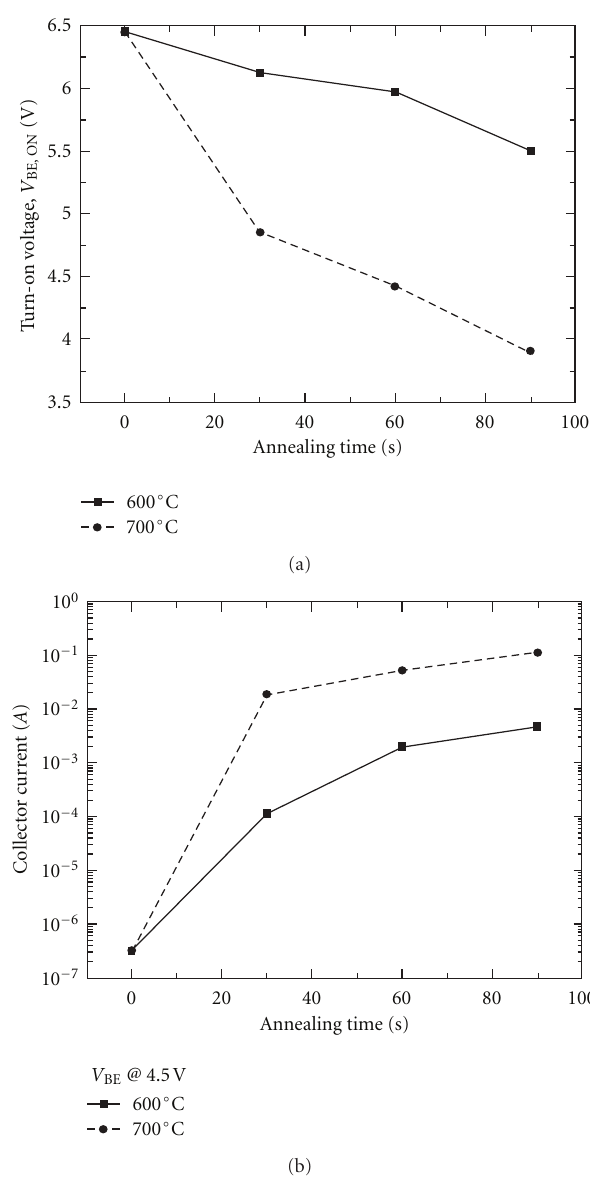
Figure 4: (a) Turn-on voltage. (b) collector current as a function of annealing time for all fabricated npn graded-base AlGaN/GaN HBT’s. A N-HBT’s is also included for